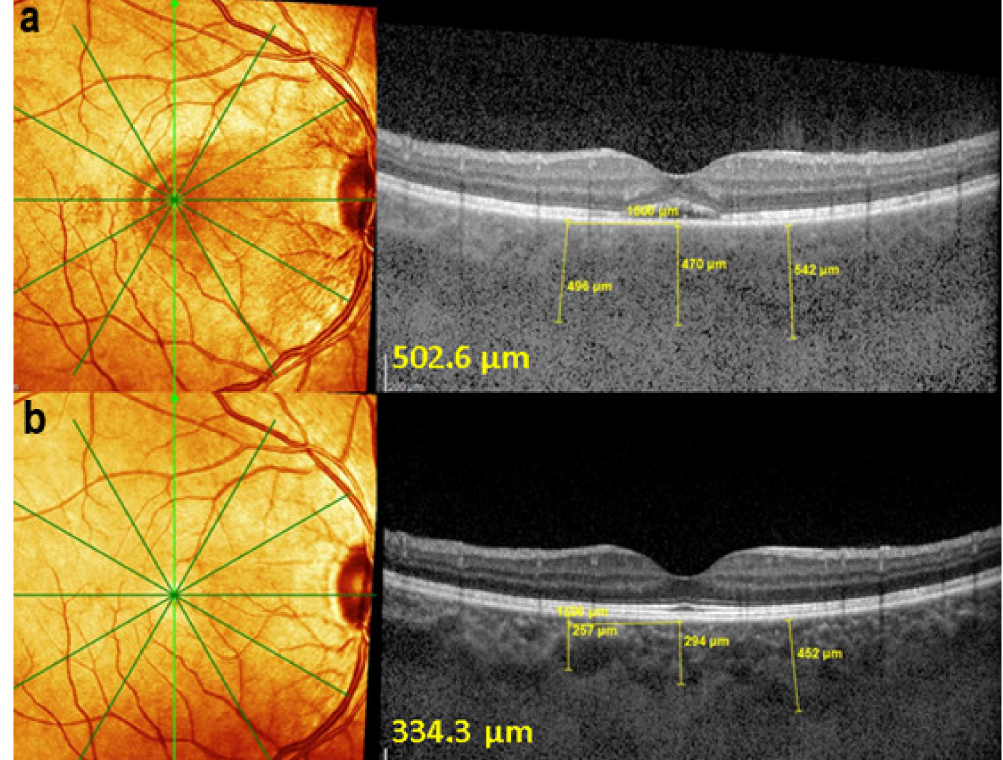
Figure 50. EDI-OCT measuring choroidal thickness in VKH disease. At presentation ( a ), mean subfoveolar thickness is increased to 502.6 µ m. After introduction of steroidal and non-steroidal immunosuppression ( b ), thickness was reduced to 334.3 µ